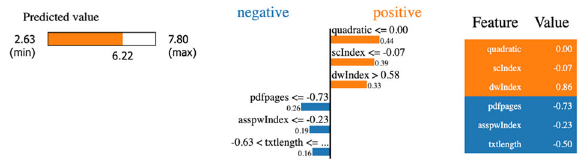
Fig. 7 LIME explanation for a document in the OpenReview dataset. The top features affecting the model are: the word “ quadratic ” , the sentence count scIndex , the number of dif fi cult words dwIndex , the number of pages pdfPages , the average number of syllables per word asspwIndex , and the text length txtlength .